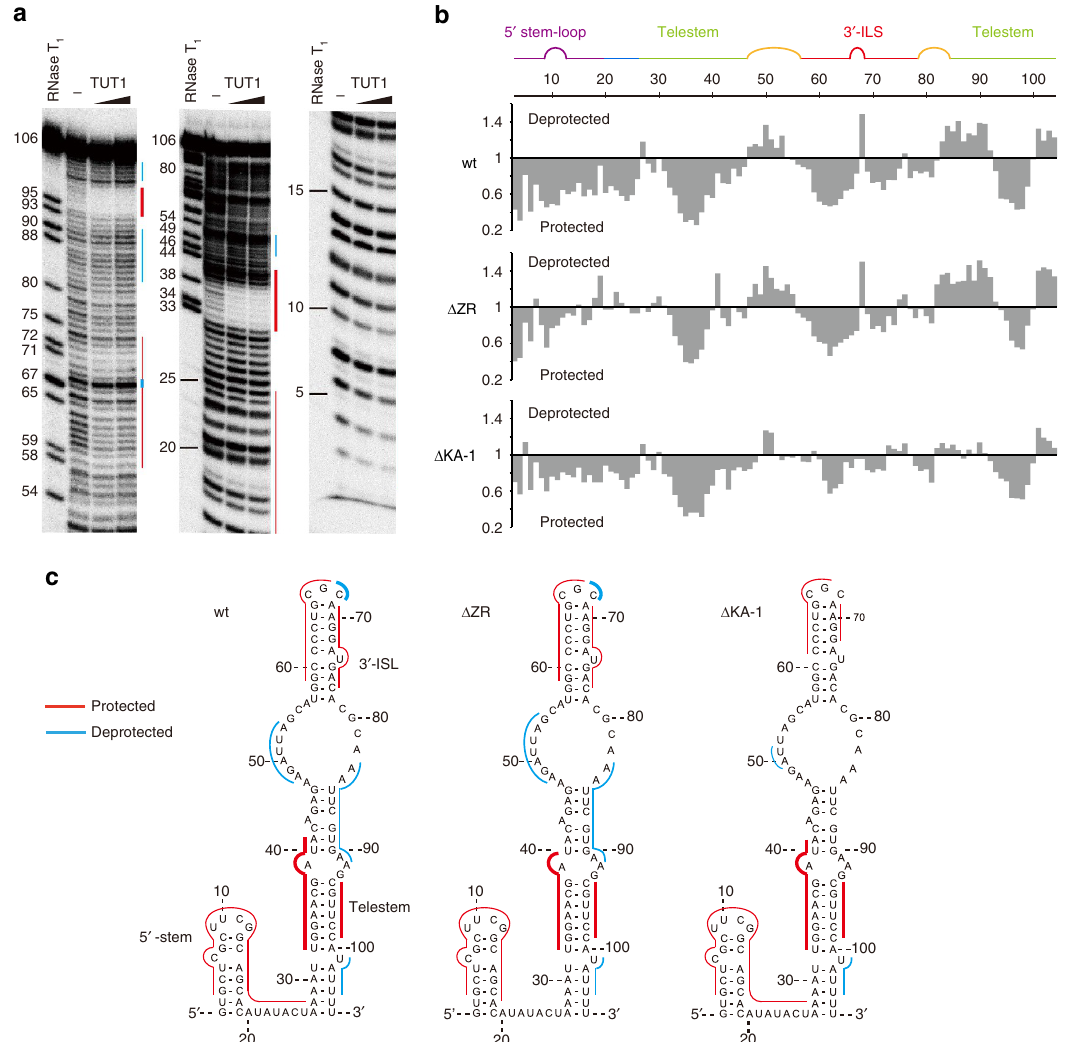
Figure 4 | Interaction of human TUT1 with U6 snRNA. ( a ) Tb(III)-mediated cleavage pattern of U6 snRNA in the absence and presence of TUT1. 32 P-labelled U6 snRNA-u4 was incubated with Tb(III) in absence or presence of 0.4 m M and 0.8 m M recombinant TUT1. Positions of nucleotides were determined by partial digestion of the RNA substrate by RNase T 1 . Cleavage patterns were analysed on 8% (w/v) (left) or 16% (w/v) (middle and right) sequencing gels. Protected and deprotected regions are depicted by red and cyan lines, respectively. ( b ) Quantitative analysis of TUT1 binding to U6 snRNA. The relative band intensities at each nucleotide position, in the presence and absence of wild-type TUT1 (upper), are shown. Quantitative analysis of D ZR (middle), and D KA-1 (lower) binding, as in wild-type TUT1 (Supplementary Figs 8,9). ( c ) Superimpositions of the footprinting data of wild-type TUT1 (left), D ZR (middle) and D KA-1 (right) onto the secondary structure of the U6 snRNA 34 . Protected and deprotected regions are coloured as in a the Nde I and Xho I sites of the pET15b (amino-acid residues 1–702 and 1–748) or diffusion method at 4 (cid:2) C. The protein concentrations were adjusted to 5mgml –1 pET22b (for the other constructs) vector (Merck Millipore, Japan). The point before use, and 1 m l of protein solution was mixed with 0.5 m l of reservoir solution. mutations of cysteine residues were introduced by the overlap PCR method. The For the crystallization of the form-I and -II crystals, TUT1_ D N with the nucleotide sequences of primers used for the mutations are shown in Supplementary C372A/C415A/C501A/C504S and C372A/C399A/C415A/C501A/C504S/C574A Table 2. E. coli BL21(DE3) (Novagen, Japan) was transformed by the plasmids, and the mutations were used. The protein solution (5mgml –1 concentration) was transformants were grown at 37 (cid:2) C until the A 600 reached 1.0. The expression of the supplemented with 10mM DTT and 100mM sodium acetate before use. TUT1 protein and its variants was induced by adding isopropyl- b -D- The protein solution was mixed with the reservoir solution containing 100mM thiogalactopyranoside at a 0.1mM final concentration, and incubating the cultures for Hepes-NaOH, pH 7.5, 13–15% (w/v) PEG3350 and 2–4% (w/v) tacsimate, pH 16h at 18 (cid:2) C. The cells were collected, and lysed by sonication in buffer containing 8.0. For the crystallization of the form-III crystals, TUT1_ D N with the 20mM Tris-HCl, pH 7.0, 500mM NaCl, 10mM b -mercaptoethanol, 20mM C501A/C504S mutation was used. The protein solution was mixed with the imidazole, 0.1mM phenylmethylsulfonyl fluoride and 5% (v/v) glycerol. The proteins were first purified by chromatography on a Ni-NTA agarose column (QIAGEN, Japan), and then further purified on a HiTrap Heparin column (GE Healthcare, form-IV crystals, TUT1_ D C with the C372A/C399A/C415A/C501A/C504S/C574A Japan). Finally, the proteins were purified by chromatography on a HiLoad 16/60 mutations was used. The protein solution was mixed with the reservoir Superdex 200 column (GE Healthcare, Japan), in buffer containing 20mM Tris-HCl, pH 7.0, 400mM NaCl and 10mM b -mercaptoethanol. The purified proteins were concentrated and stored at (cid:3) 80 (cid:2) C until use. The data sets were collected at beamlines 17A and NW12A at the Photon Factory at KEK, Japan. The crystals were flash-cooled with the reservoir solution Crystallization and structural determination of TUT1 . All of the crystals supplemented with cryoprotectant: 30% (v/v) ethylene glycol for the form-I and -II crystals, 30% (v/v) sucrose and 5% (v/v) ethylene glycol for the form-III crystals used for the structural determination were prepared by the hanging drop vapour